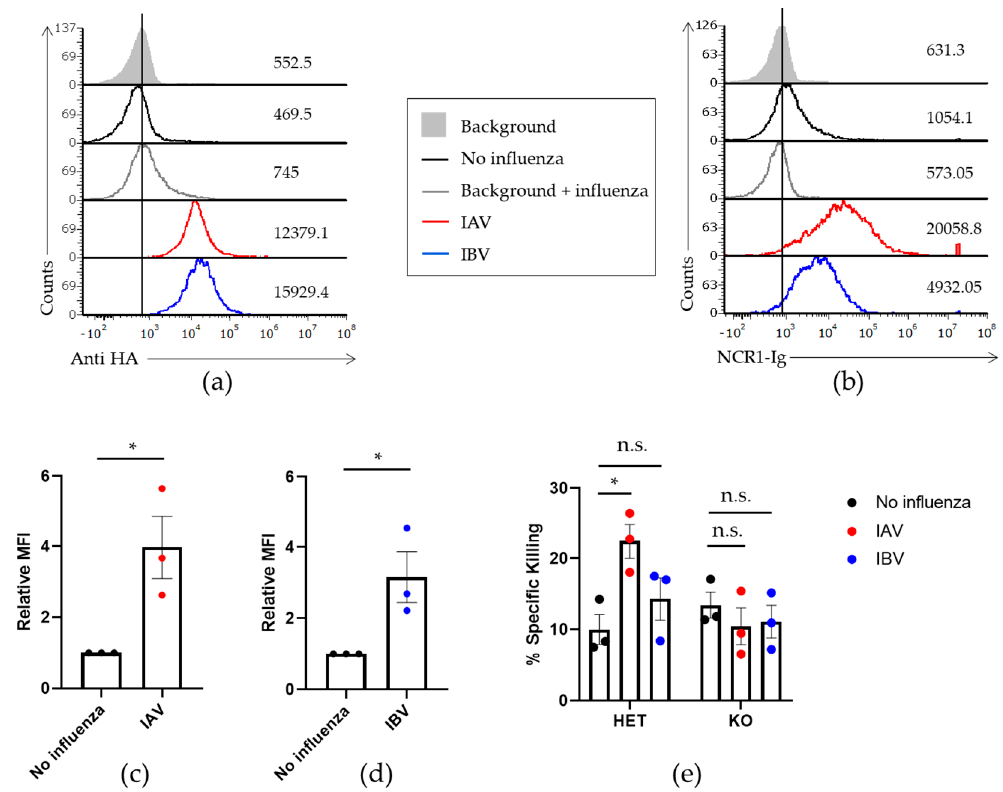
Figure 5. NCR1 binds to IBV but does not activate killing by mouse NK cells. ( a , b ) EL4 cells were incubated or not (black histogram) with IAV or IBV. ( a ) FACS staining of IAV (red histogram) and IBV (blue histogram) with antibodies against the hemagglutinin of IAV and IBV, respectively. ( b ) The cells incubated with the indicated viruses were stained with NKp46-Ig fusion protein. The filled histograms and gray empty histograms represent the staining with secondary antibodies only in the absence or presence of influenza, respectively. Figure shows one representative experiment out of three performed. ( c , d ) MFI quantification of three independent experiments including data presented in ( b ). FACS staining with NCR1-Ig against IAV ( c ) and IBV ( d ) was normalized to the staining of the cells without influenza. Values are shown as mean ± SEM. * p < 0.05 by two-tailed paired Student’s t test. ( e ) NK cells from Ncr1+/gfp (HET) and Ncr1gfp/gfp (KO) mice were extracted and incubated with EL4 cells in the presence or absence of IAV and IBV. Killing assay was performed as mentioned above. An ANOVA test was performed in order to evaluate significance. Values are shown as mean ± SEM. * p < 0.05. Figure shows cumulative results of three independent experiments.